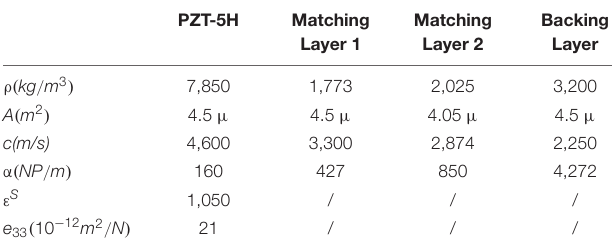
TABLE 1 | The parameters of PZT-5H for Leach model.